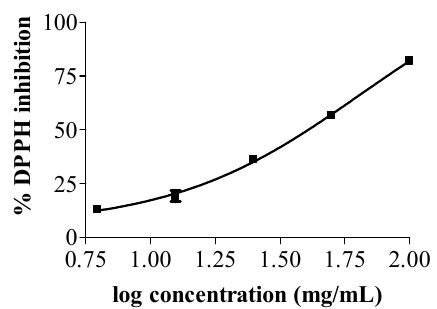
Figure 2 . Dose response curve of DPPH inhibition versus log concentration of CA ( R 2 = 0 . 998 ± 0 . 002 ). Figure 2. Dose response curve of DPPH inhibition versus log concentration of CA (R 2 = 0.998 ± 0.002).